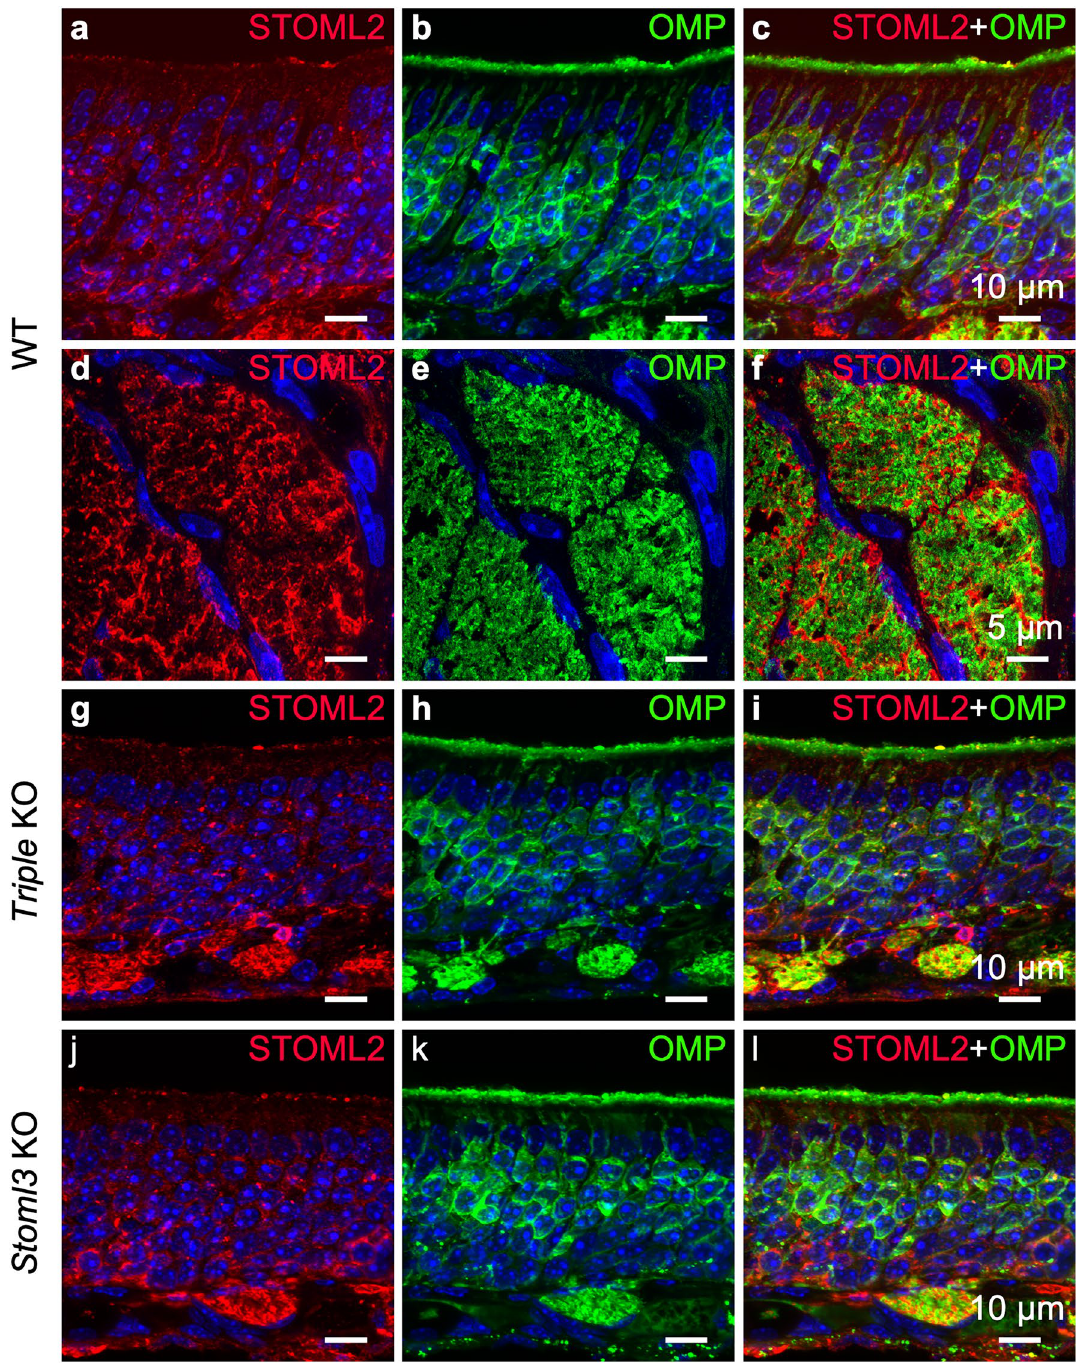
Figure 6. STOML2 is expressed in olfactory sensory neurons, basal stem cells and ensheathing cells. Confocal micrographs at high magnification of coronal sections of the OE of WT ( a – c ), triple KO ( g – i ) and Stoml3 KO ( j – l ) mice, double-stained with anti-STOML2 (red) and anti-OMP (green) antibodies. In all the three mice models, STOML2 has a punctate pattern spread throughout the OE. STOML2 is detected in the soma of the OSNs, although it is almost absent in the ciliary layer. STOML2 signal also is observed in the most basal region of the OE where locate the basal stem cells. ( d – f ) Higher magnification of OSN axon bundles shows the localization of STOML2 in ensheathing cells. Nuclei were stained with DAPI